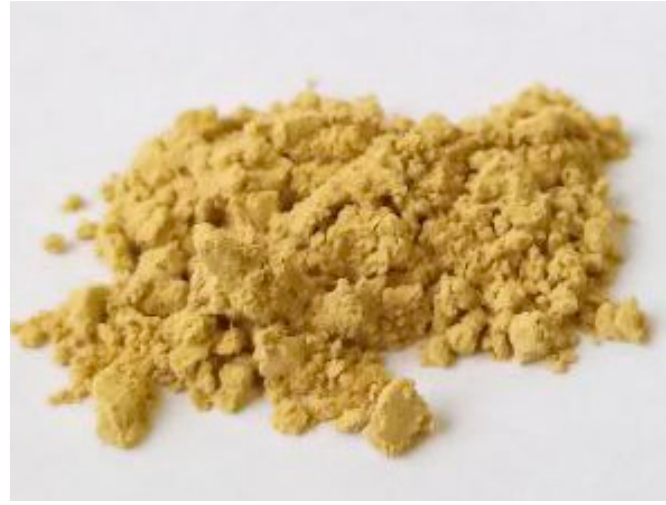
Figure 1. Photo of wheat straw powder.